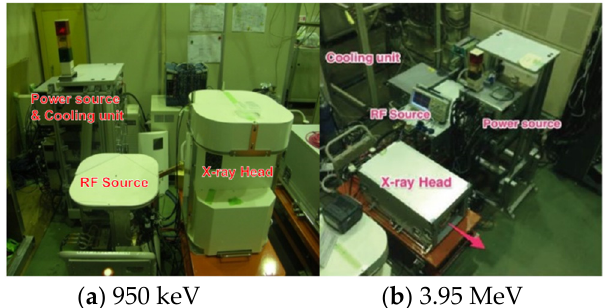
Figure 9. Portable X-band LINAC-based X-ray sources. The systems are composed of three units: X-ray head, magnetron, and power units. ( a ) 950 keV; ( b ) 3.95 MeV. Table 1. Specifications of X-ray sources.